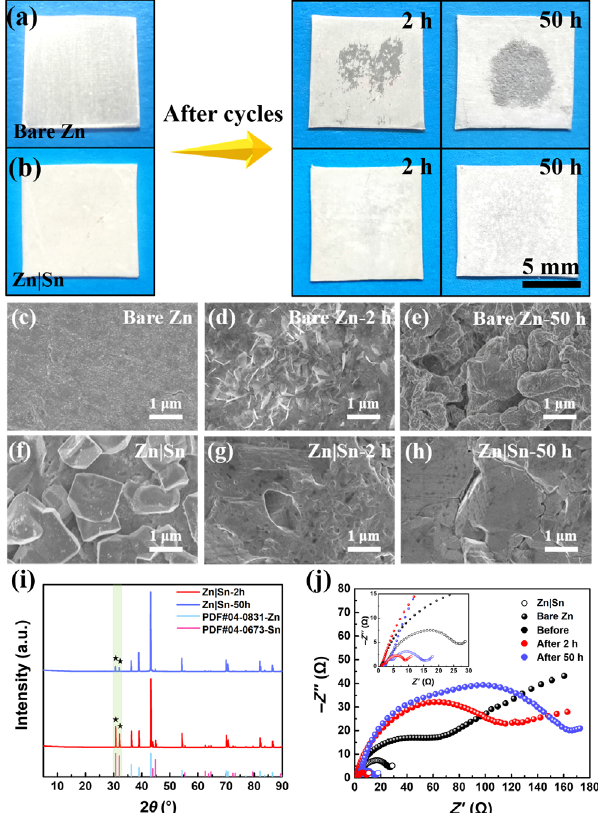
Figure 4 Optical photographs of bare Zn (a) and Zn|Sn (b) before and after 50 h. SEM images of bare Zn ((c)–(e)) and Zn|Sn ((f)–(h)) before and after cycles at 1 mA·cm −2 for 1 mAh·cm −2 . (i) XRD patterns of Zn|Sn after cycles. (j) EIS of bare Zn and Zn|Sn before and after cycles in symmetric